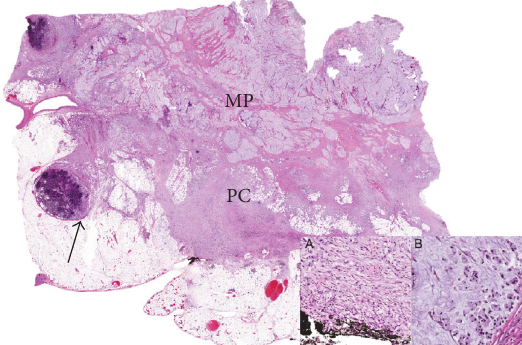
Figure 1: Signet-ring cell adenocarcinoma infiltrating through the muscularis propria (MP) into pericolic adipose tissue (PC) and involving regional lymph nodes (arrow). The signet-ring cells are seen infiltrating through tissue and extending to the serosal surface (A) and are seen floating in mucin